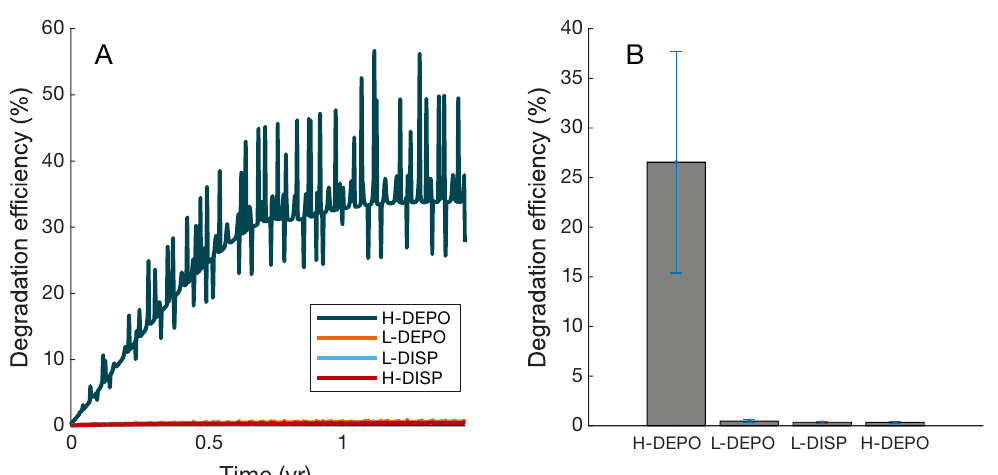
Fig. 3. (A) Evolution of degradation efficiency of organic wastes (not ambient deposits) throughout a single fish farm produc- tion cycle according to parameters of Table 1. Simulations were carried out assuming a feed wastage of 3%, twice-per-day feeding (for 20 min each), and a constant water depth of 20 m below the fish cage (35 m in total). Simulations are presented for 4 different hydrodynamic scenarios: high and low deposition (H- and L-DEPO) and low and high dispersion (L- and H--